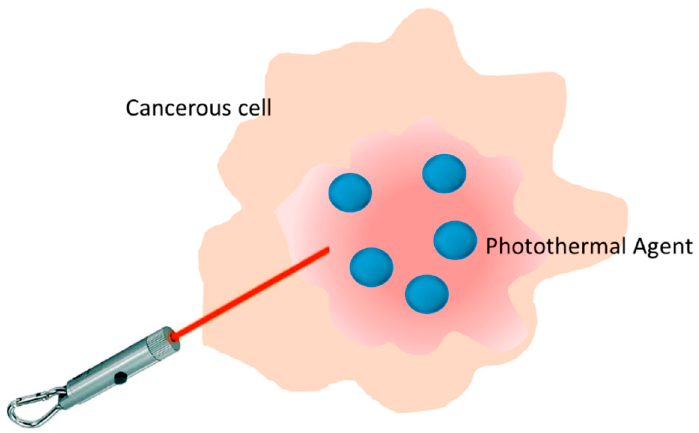
Figure 1. Basis of the photothermal therapy: the tumor containing the photothermal agents is irradiated with a laser. The radiation absorbed by the photothermal agents is converted to thermal energy causing cell death in the vicinity.